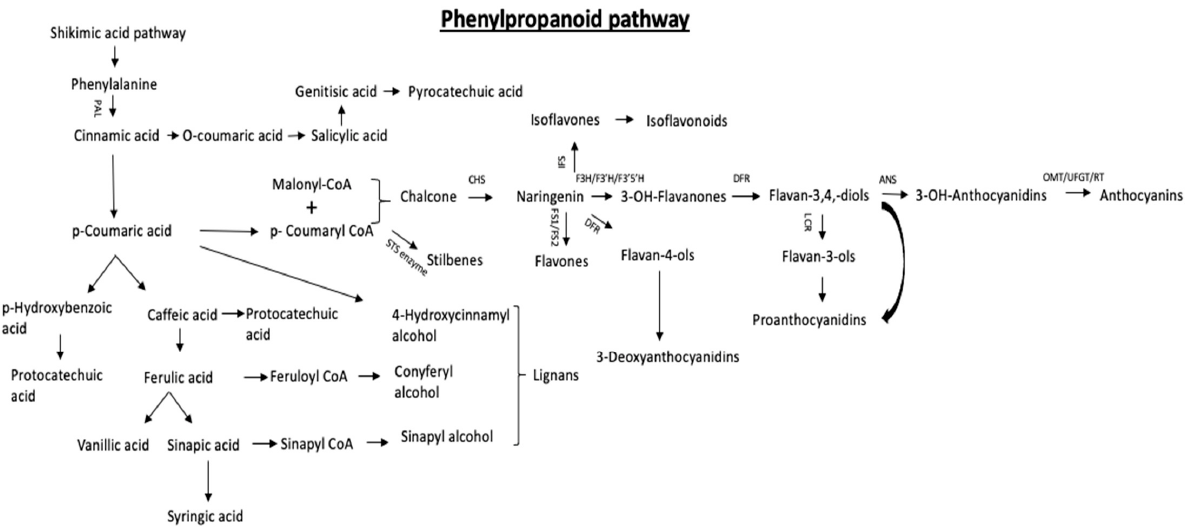
Figure 2. Schematic of phenylpropanoid pathway leading to synthesis of different polyphenols i.e., phenolic acids, flavonoids, stilbenes and lignans by the action of various enzymes.